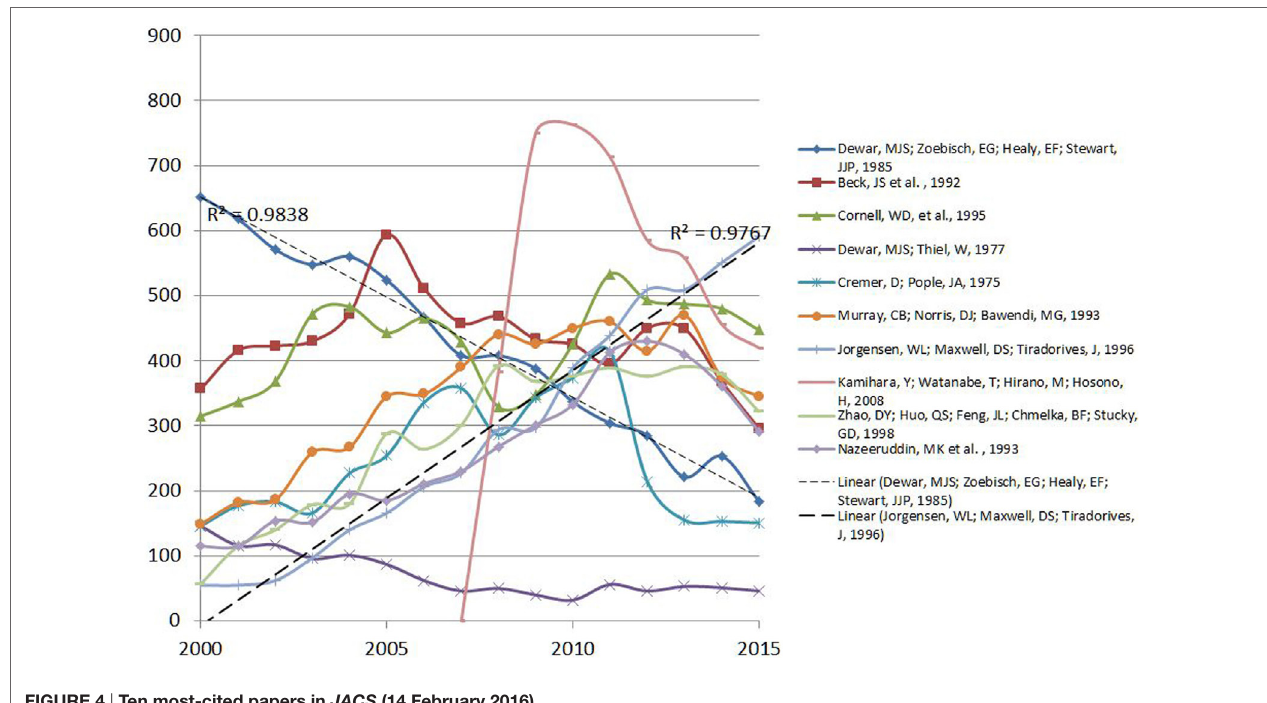
FigUre 4 | Ten most-cited papers in JACS (14 February 2016) .